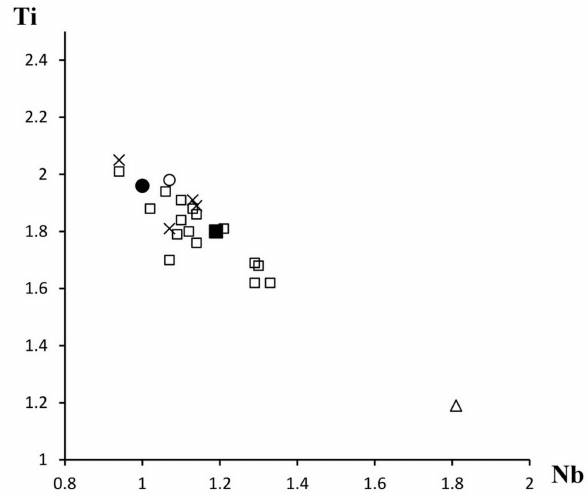
Figure 8. Correlation between contents of Ti and Nb ( apfu ) in zirconolite-type minerals from the Laach Lake volcano. Correlation coefficient R = –0.932. For legend see Figure